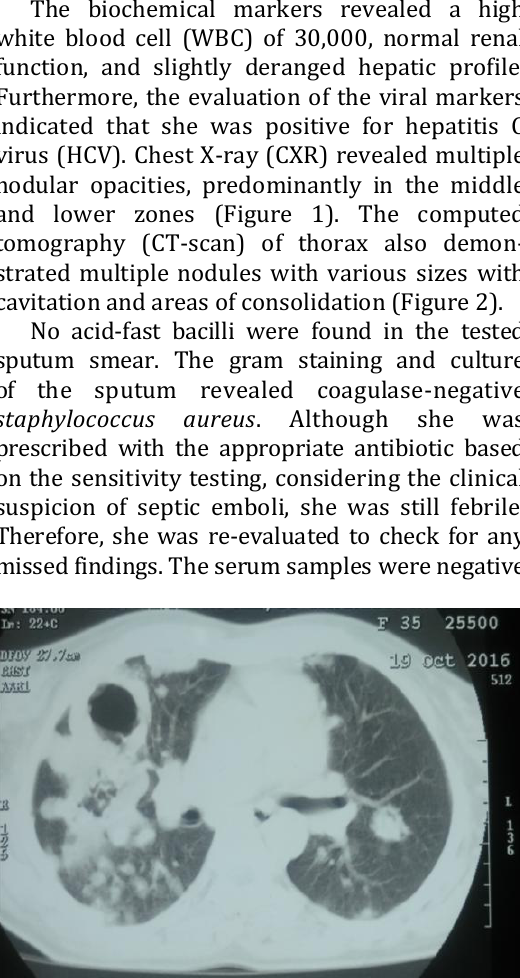
Figure 1 . Chest X ray of patient showing bilateral nodular opacities found on the lower inner quadrant of her right breast. Systemic examination was normal except for the presence of bilateral basal crepitations of the lungs.